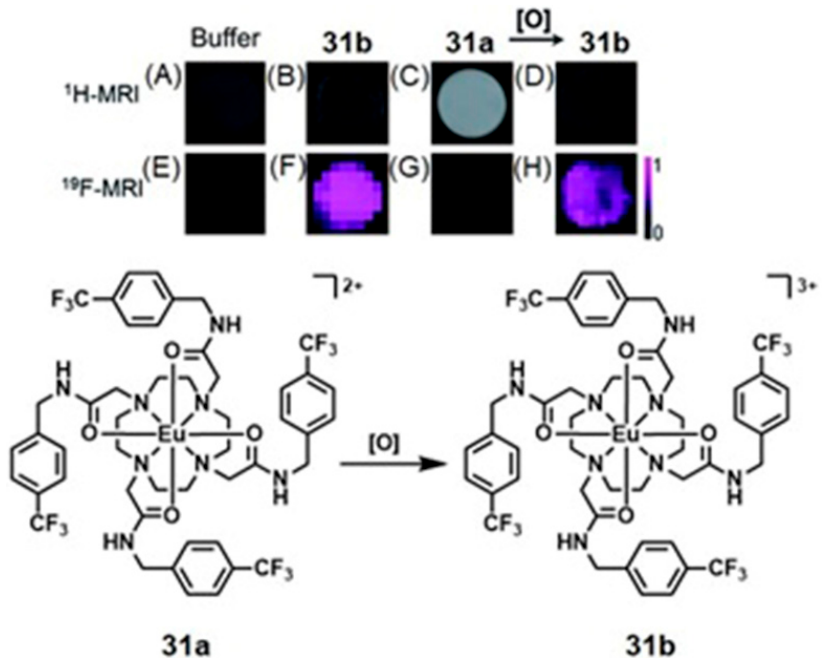
Figure 65. T 1 -weighted MRI images of solutions of ( A ) aqueous 3-morpholinipropane-1-sulfonic acid buffer (20 mM, pH 7.0); ( B ) 31b (3.5 mM); ( C ) 31a (3.5 mM); ( D ) 31b after oxidation of 31a (3.5 mM). 19 F-MRI images of ( E ) aqueous 3-morpholinipropane-1-sulfonic acid buffer (20 mM, pH 7.0); ( F ) 31b (3.5 mM); ( G ) 31a (3.5 mM); ( H ) 31b after oxidation of 31a (3.5 mM). The scale bar on the right of (H) represents signal intensity for all 19 F-MRI images in the figure. Chemical structures of 31a (left) and 31b (right). Adapted with permission of the Royal Society of Chemistry, from Fluorinated Eu II -based multimodal contrast agent for temperature- and redox-responsive magnetic resonance imaging, Basal, L. A.; Bailey, M. D.; Romero, J.; Ali, M. M.; Kurenbekova, L.; Yustein, J. T.; Pautler, R. G.; Allen, M. J. 8 , 12, 2017 ; permission conveyed through Copyright Clearance Center, Inc. [393].